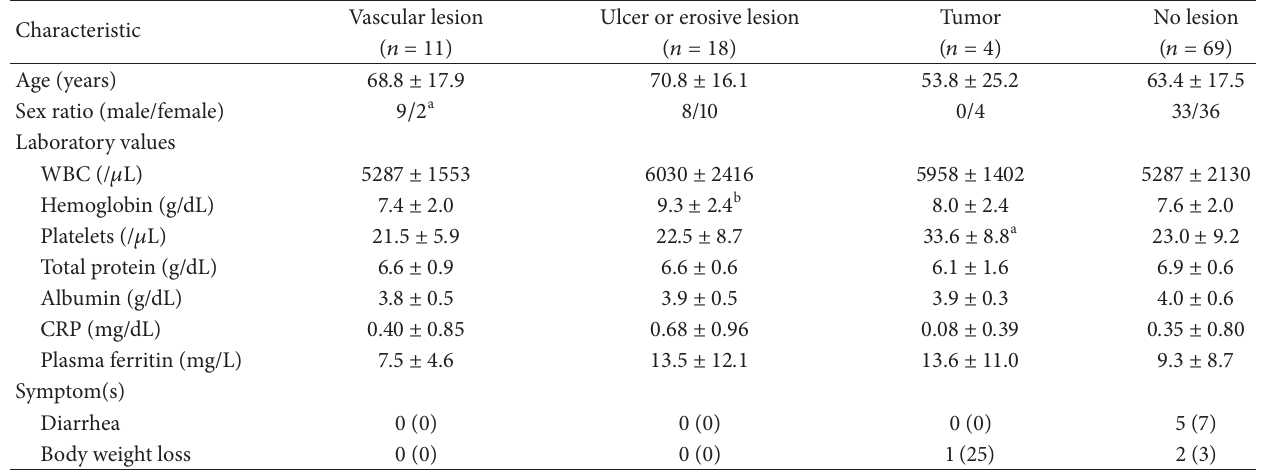
Table 5: Clinical characteristics of patients with occult OGIB, per